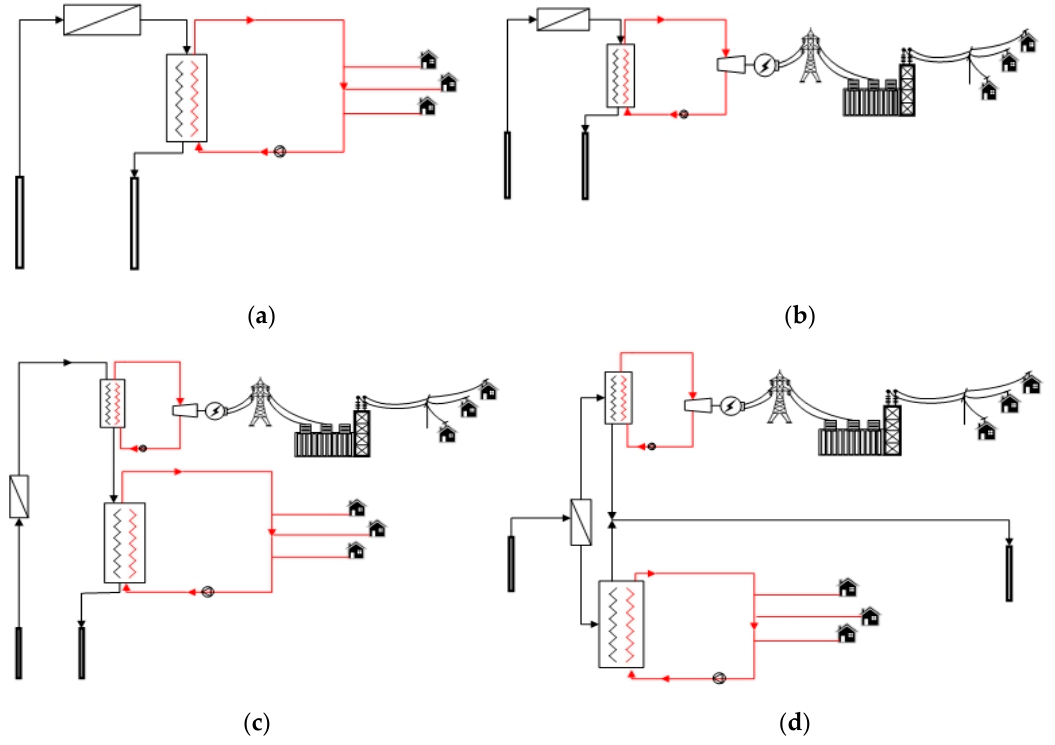
Figure 4. Schematic description of the possible end-user options: ( a ) direct use, ( b ) only electricity production, ( c ) combined heat and power (CHP)–series configuration, ( d ) CHP–parallel configuration.